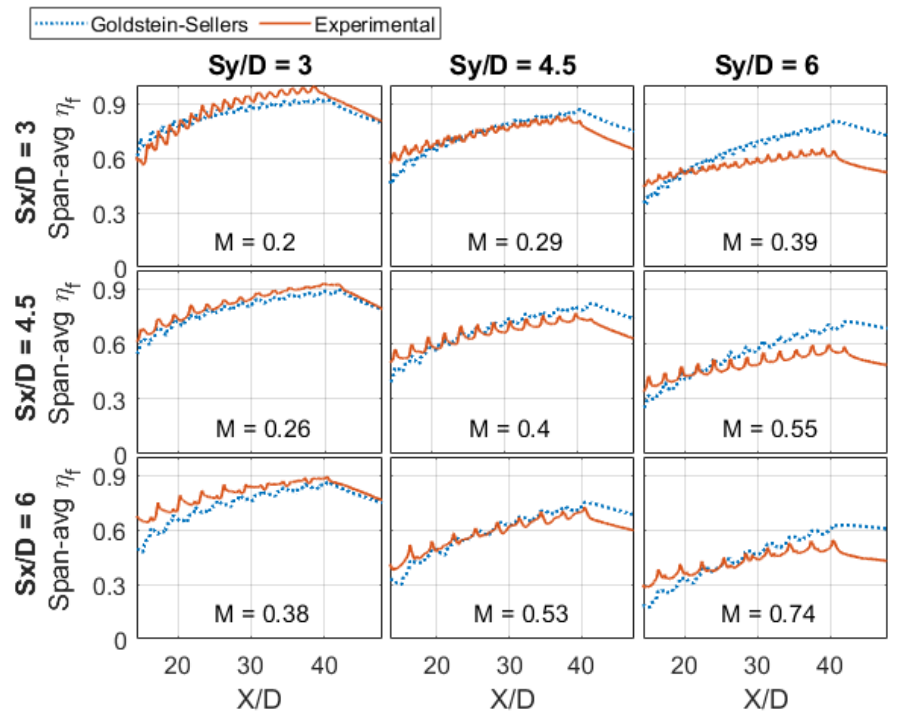
Figure 17. A comparison of numerical and experimental spanwise-averaged film effectiveness for m ∗ =